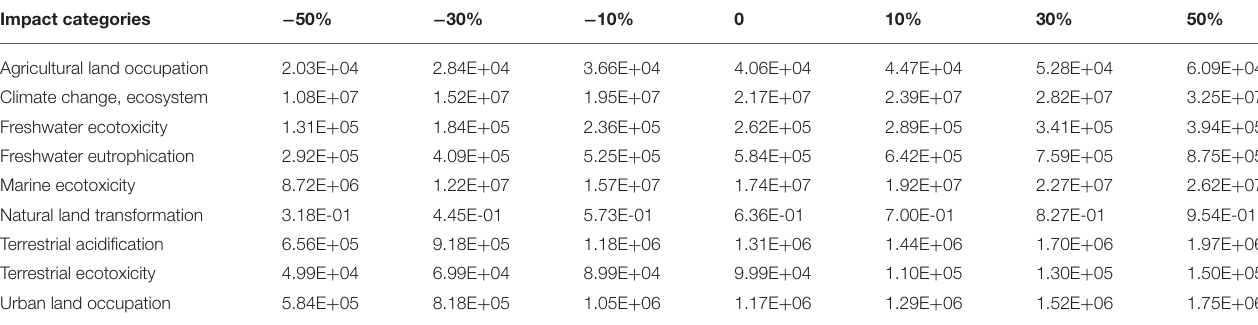
TABLE 4 | Sensitivity analysis results for quantitative variations across each endpoint impact category for production phase (in